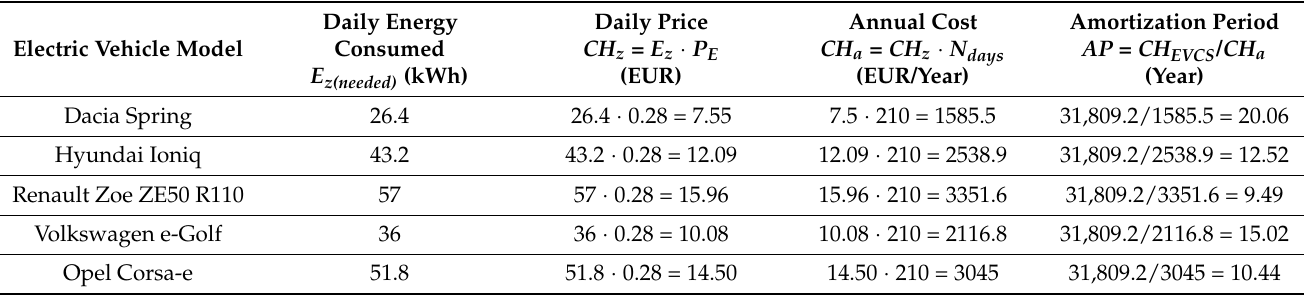
Table 6. Amortization period for EVs connected to